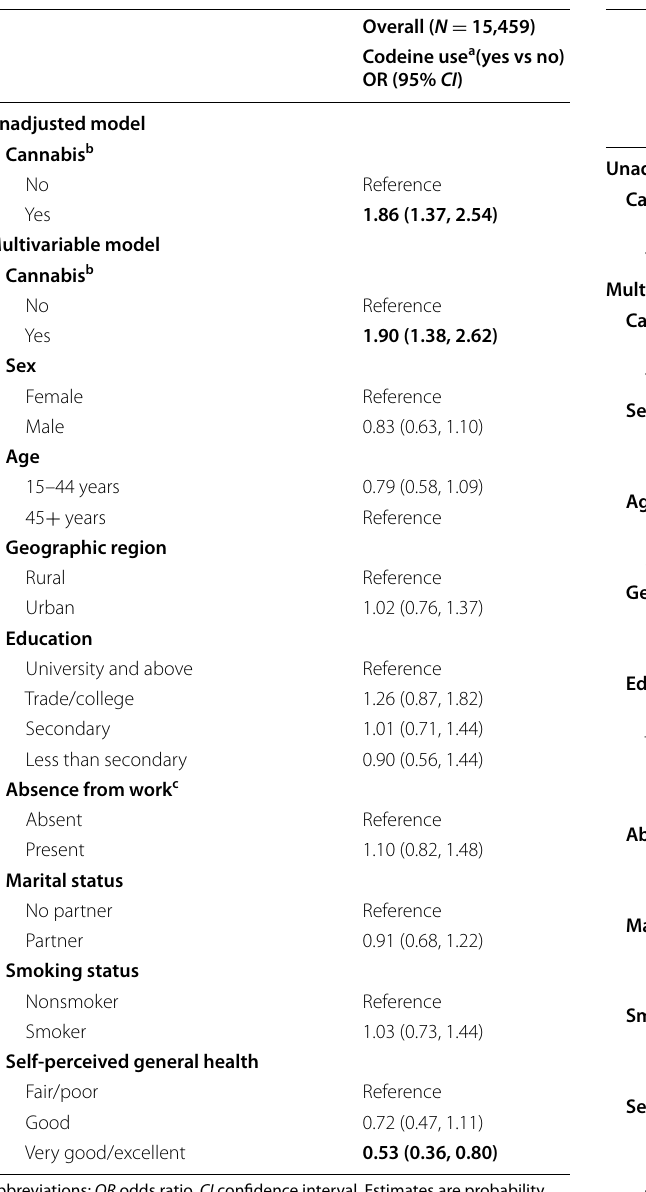
Table 3 Unadjusted and adjusted logistic regression models evaluating the association between cannabis and codeine use among the Canadian Population, Canadian Tobacco, Alcohol and Drugs Survey (2017)